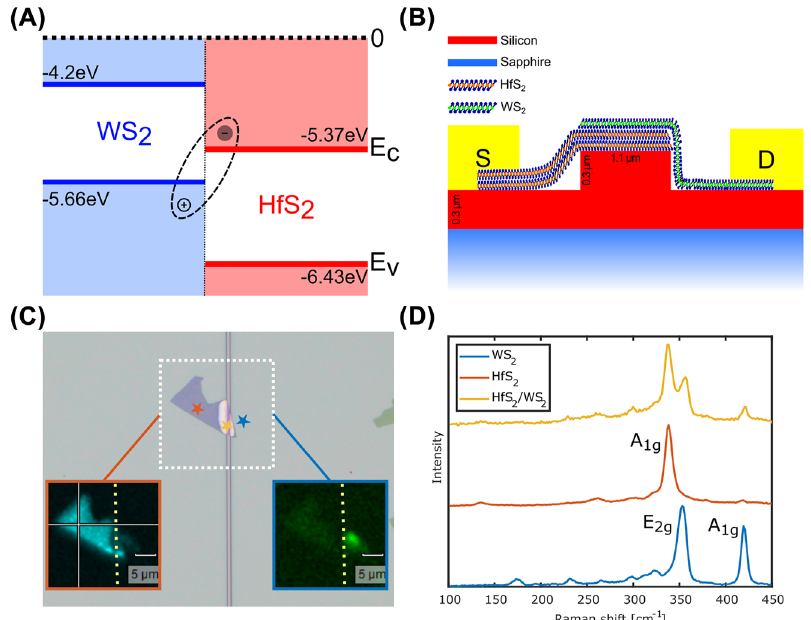
Figure 1: Device structure. (A) Heterostructure band diagram, the energy values of the band edges are relative to the vacuum level and taken from [23]. (B) Schematic description of the device. (C) Optical image of the device without the electrical contacts; the WS visible. The Blue (bottom right) and red (bottom left) insets show the measured Raman signal from the WS respectively. The dashed yellow lines in these insets represent the location of the waveguide. (D) Raman spectra of the individual layers and the heterostructure; the curves are shifted for